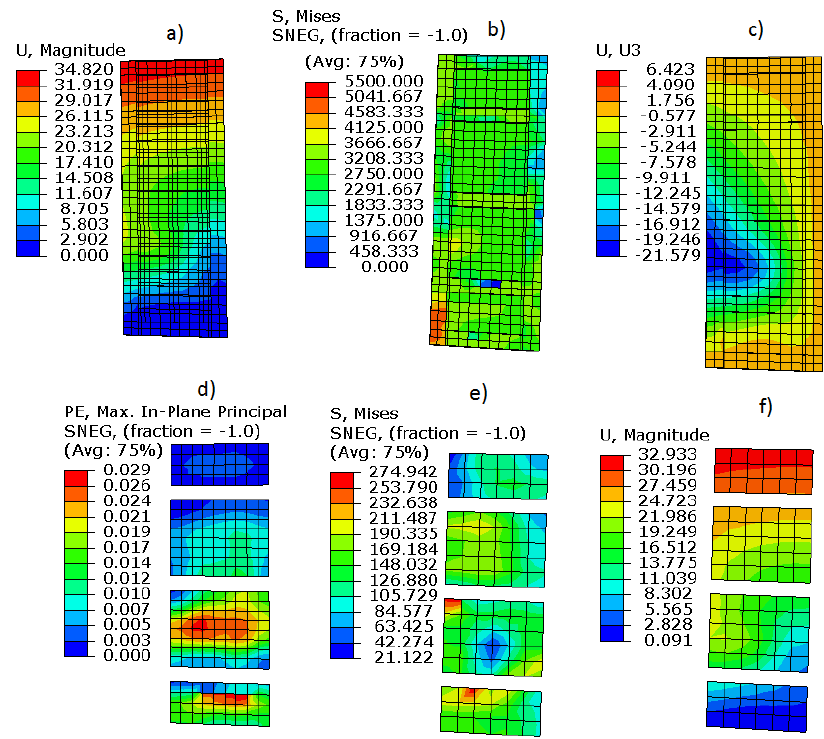
Figure 4. Performance of steel and concrete plate for verification model ( a ) displacement; ( b ) frame stress; ( c ) out of plane displacement; ( d ) plastic strain ( e ) concrete stress ( f ) concrete displacement).